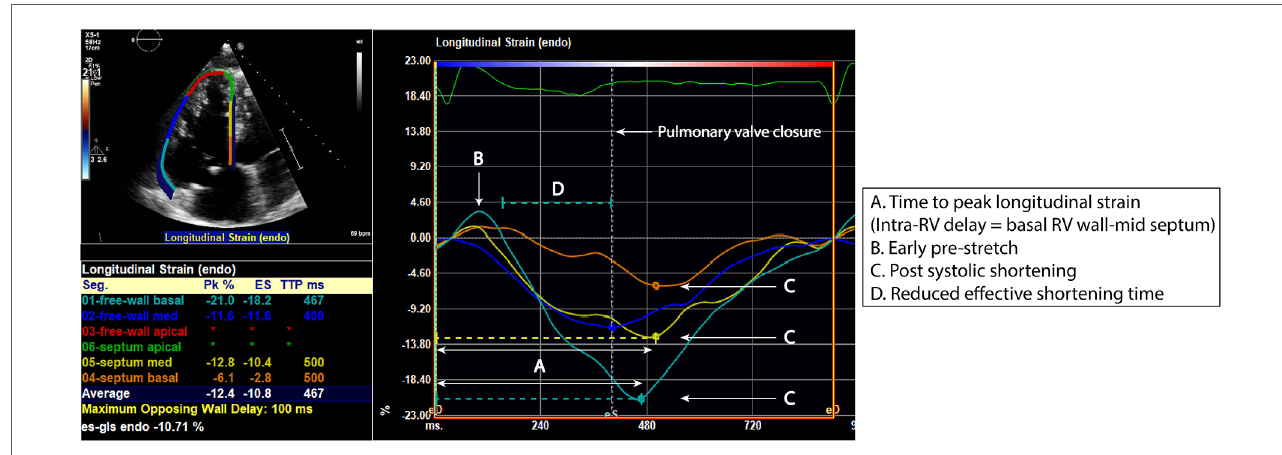
FIGURE 2 RV segmental strain curves in a repaired ToF patient with evidence of right ventricular (RV) dyssynchrony. Time to peak longitudinal strain ( A ) of the RV lateral wall and septum is measured at the basal and mid segments. There is presence of basal lateral wall pre-stretch ( B ) and post systolic shortening of the basal lateral wall and basal to mid septum ( C ). These characteristics result in a reduced effective shortening time ( D ).